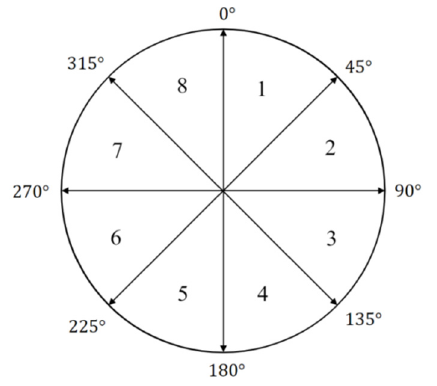
Figure 3. Eight directions for mouse dynamics feature extraction.